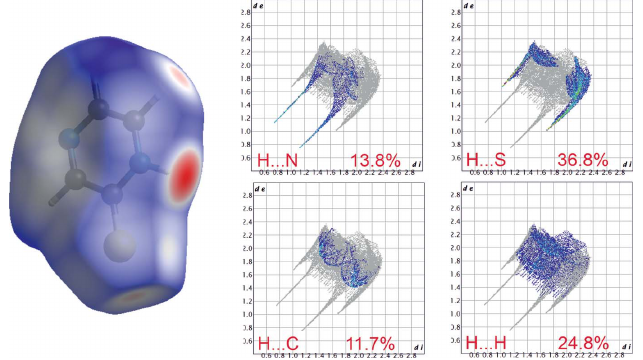
Figure 1 . Molecular formulae of pyrazine-2(1 H )-thione (I), 2-mercaptopyrazine (II) and isonicotinic acid N -oxide